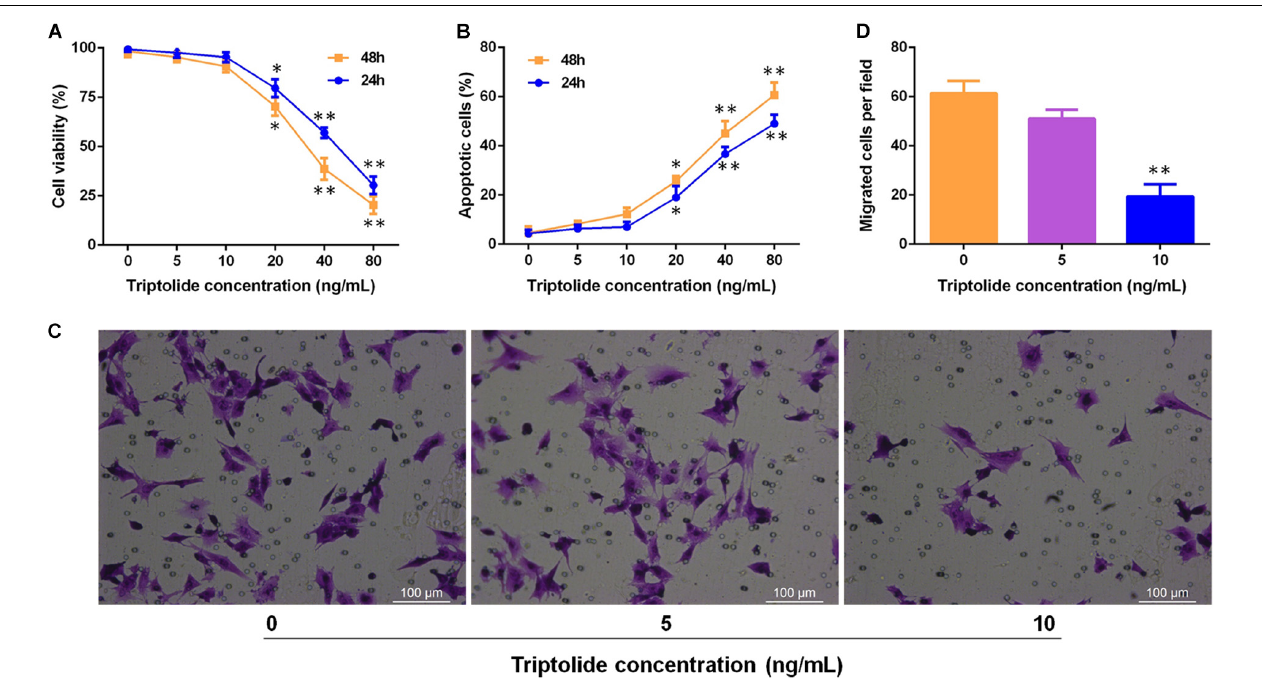
FIGURE 7 | Triptolide significantly inhibits migration of VSMCs without affecting the viability and apoptosis of VSMCs. (A) Cell viability was assessed using the CCK-8 assay. (B) Cell apoptosis was detected by flow cytometry. (C) Cell migration was assessed through the Transwell migration assay. VSMCs were incubated in culture media containing various concentrations of triptolide (0, 5, and 10 ng/mL) for 24 h. Representative images of VSMCs that migrated through the gelatine to the lower-chamber side of Transwell membranes. (D) Quantification of the Transwell migration assay results. Data were represented as mean ± SD. Each experiment was performed three times. ∗ p < 0.05, ∗∗ p < 0.01 vs. untreated Student’s t-